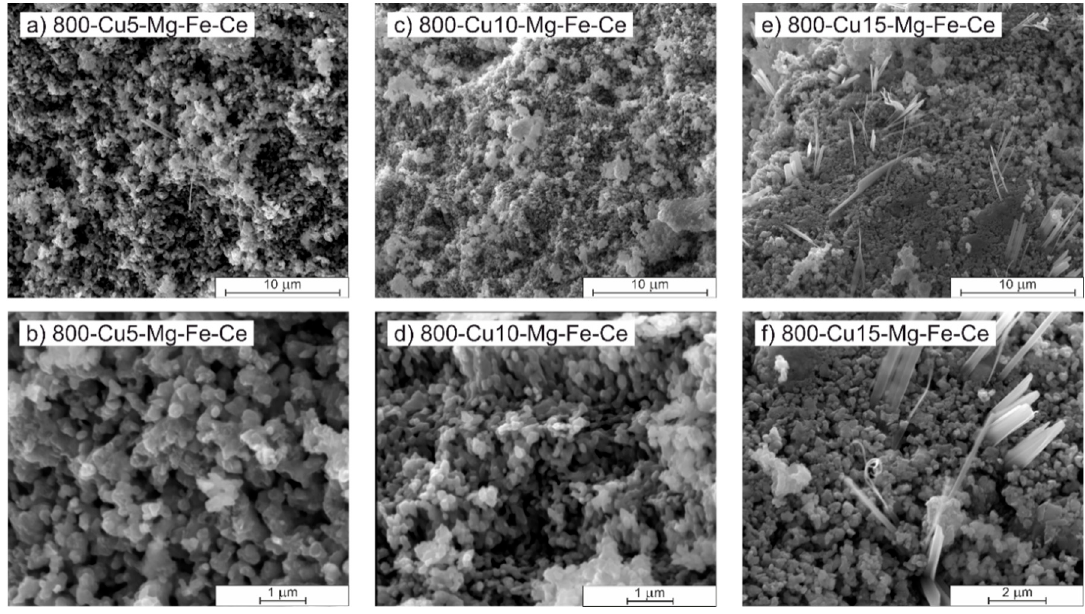
Figure 3. SEM micrographs of ( a ), ( b ) 800-Cu5-Mg-Fe-Ce (SE mode), ( c ), ( d ) 800-Cu10-Mg-Fe-Ce (SE mode), ( e ), ( f ) 800-Cu15-Mg-Fe-Ce (SE mode).